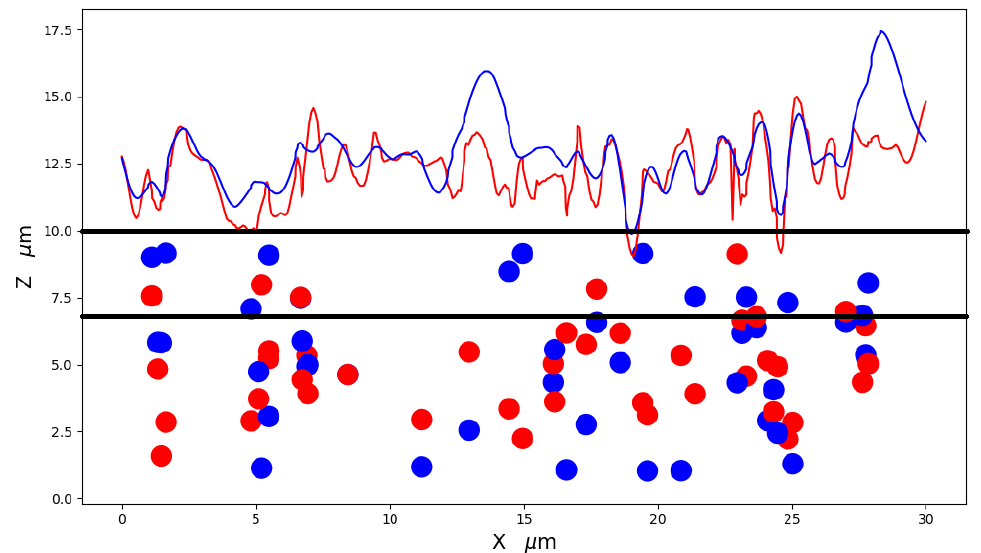
Figure 8. Cross section of the 3D surface for test 2 comparison of initial profile (red line) and modified profile (blue line). Parallel horizontal black lines represent the band of 30% of the total height of the initial simulation box.